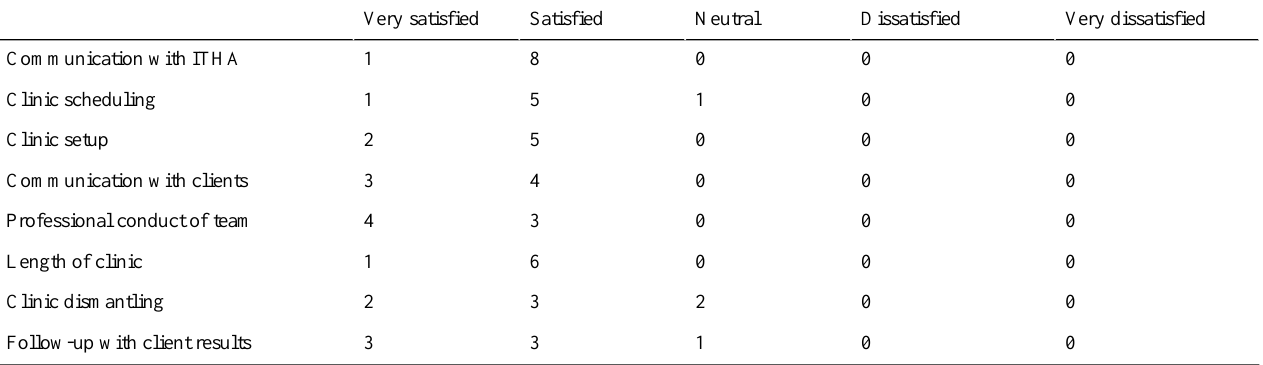
Table 4. Satisfaction ratings for retinal screening clinics